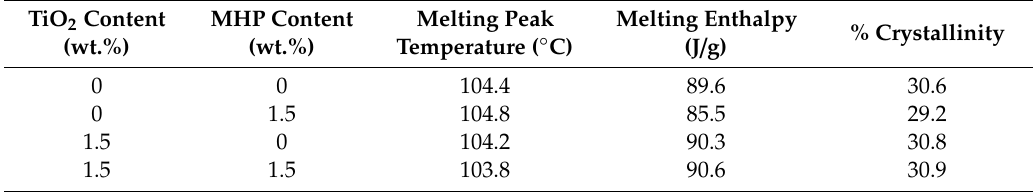
Table 1. DSC results for LDPE and LDPE with TiO 2 and MHP fillers.